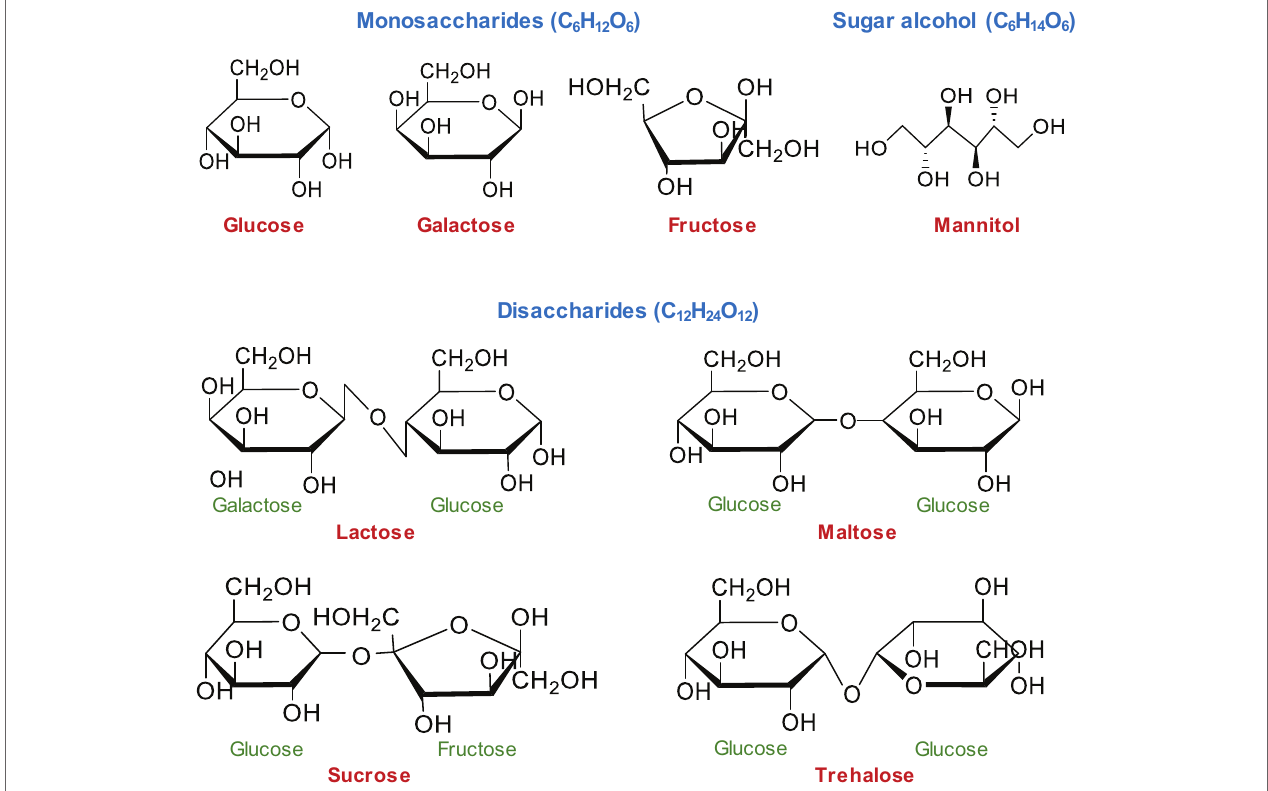
FIGURE 1 | Chemical structure of mono- and disaccharide sugars and sugar alcohol tested in this study. Haworth projections of the chemical structures were drawn using ChemDraw JS